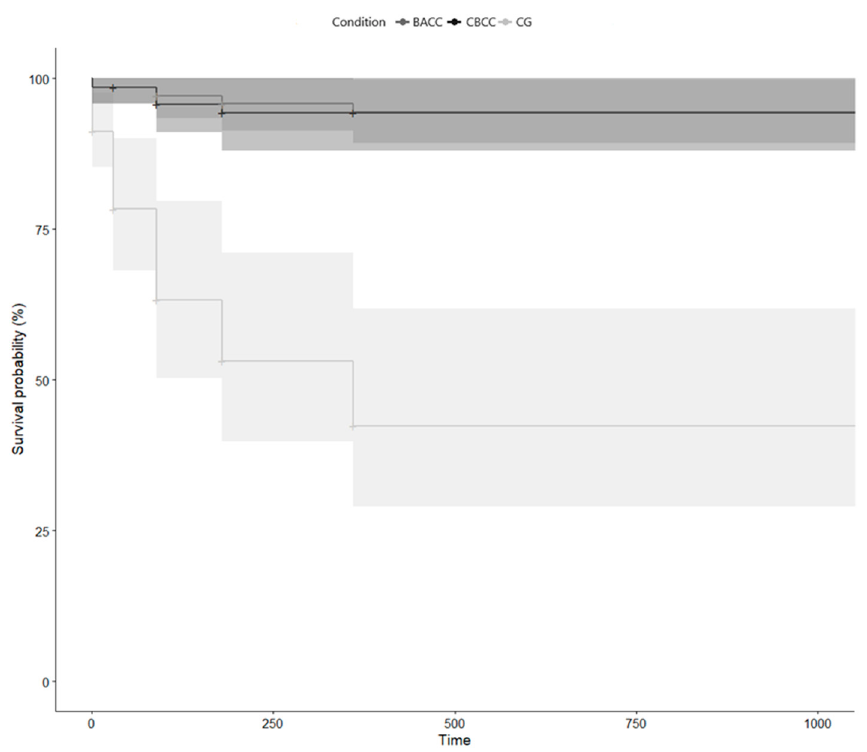
Figure 3. Cumulative survival for recurring events for the different experimental conditions.